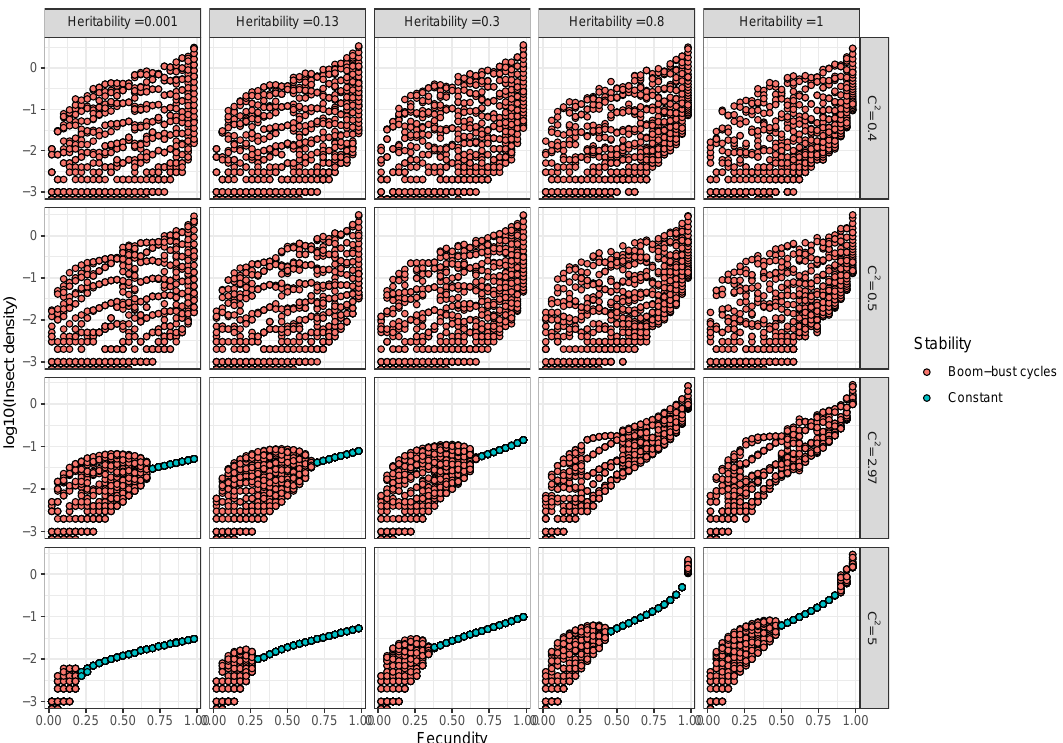
Figure 6. Insect density as a function of fecundity, heterogeneity of transmission, and the heritability of transmission as predicted by the evolution model (Model 3) where low transmission is costly to reproduction. For any given value of insect fecundity multiple insect densities (dots) occur whenever the insect population cycles through time. Thus, the dot range across the y-axis indicates the cycle amplitudes, whereas the number of dots indicate the frequency of recurring cycle peaks or troughs averaged over a period of 30